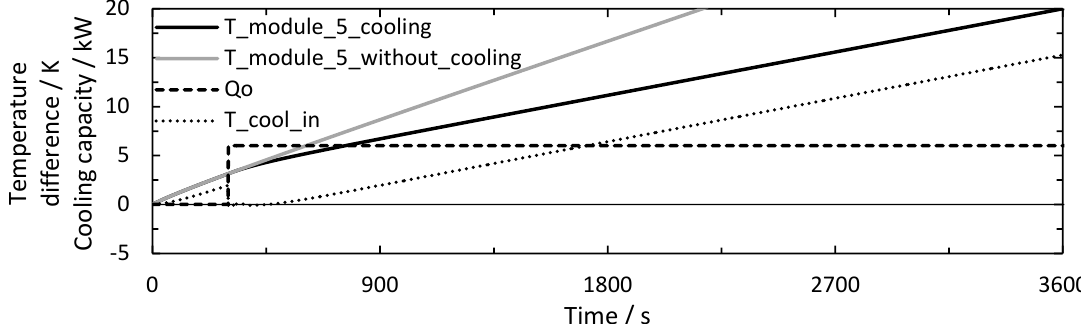
Figure 13. Coolant temperature, coolant capacity, and controlled and uncontrolled mean battery cell temperature of module 5 for a charging rate of 1 C. The temperature difference refers to the initial conditions.